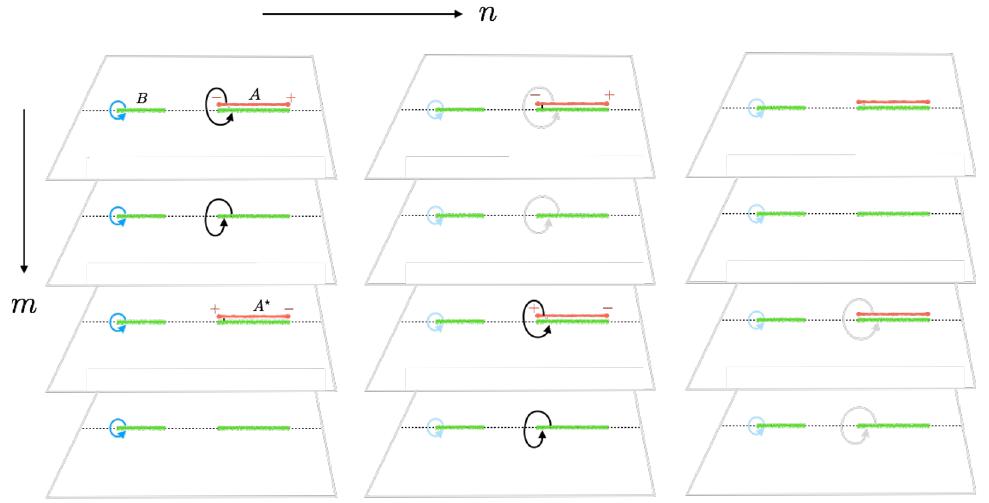
Figure 8 . Including the n -fold replication of the space M m we arrive at the above picture (shown here with m = 4 and n = 3 .) Some simple curves on this space are depicted. The red cuts move you in the horizontal direction and the green in the vertical